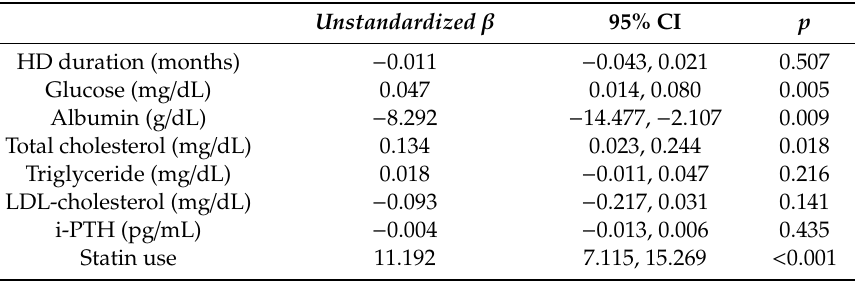
Table 2. Determinants for PCSK9 level in HD patients.